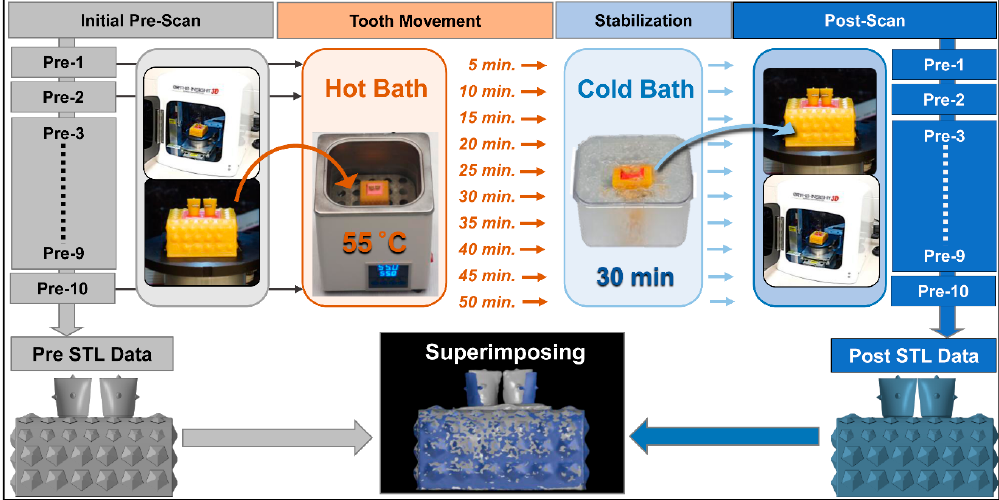
Figure 2. Experiment flowchart.